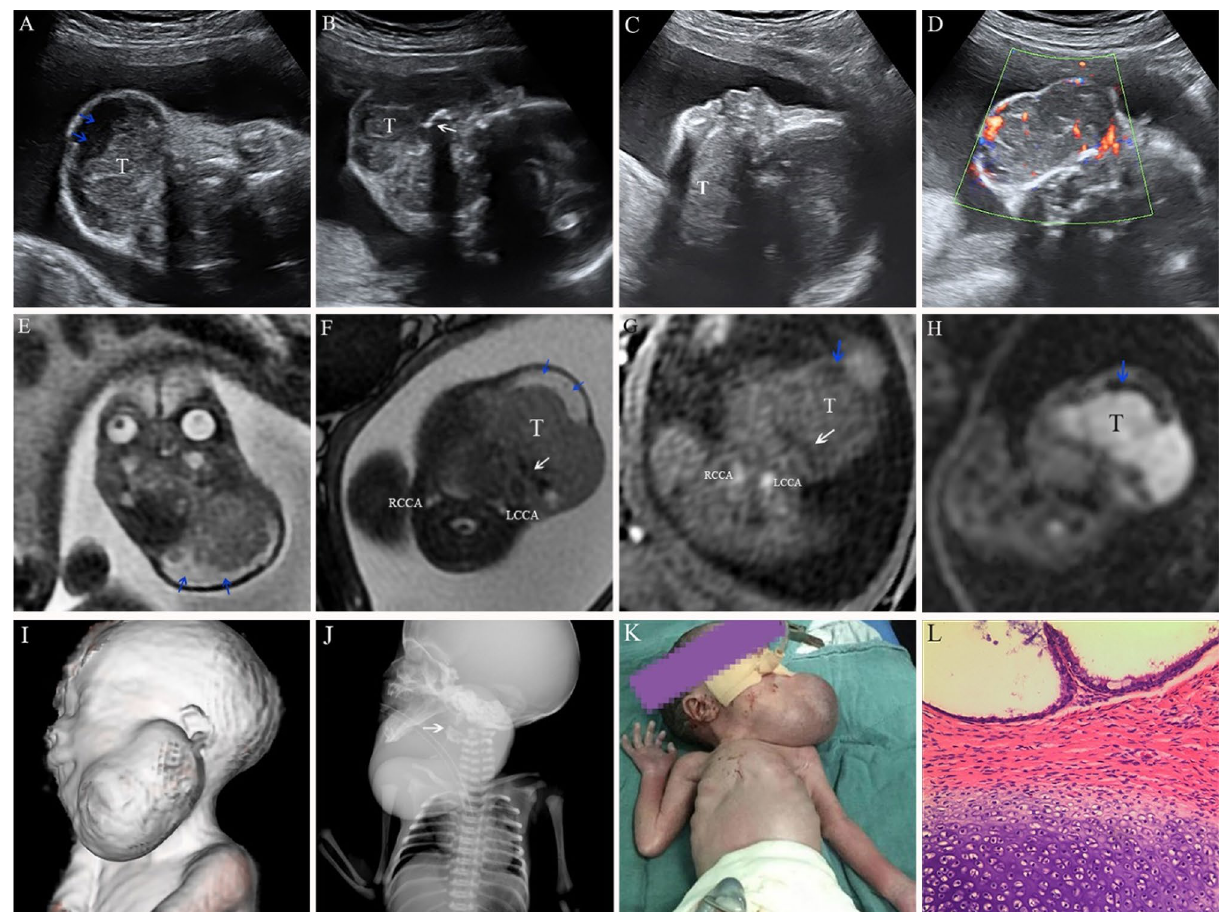
Figure 2. A submandibular teratoma at 29 weeks of gestational age. ( A–D ) Upon prenatal ultrasonic imaging, we found that the giant tumour (T) was with a slightly high intensity echo, high echo lesions with posterior acoustic shadowing at the central region (white arrow), capsule echo at marginal region (blue arrow). Color Doppler imaging showed rich internal blood flow. ( E–I ) On fetal MRI, the lesion was cystic-solid, calcified foci is striped low signal. Diffusion weighted imaging (DWI, b = 800) showed diffusion restriction in solid region (Fig H). Left and right internal carotid arteries were clearly visible (Fig F, Fig G). MR volume reconstruction (VR) image clearly showed the relationship and morphology of mass. ( J ) Neonatal radiography demonstrated huge high-density lesions with calcification (white arrow) under the jaw. ( K ) Image of the newborn after endotracheal intubation. ( L ) The pathological specimen was confirmed to be a mature cystic-solid teratoma (HE staining, × 100 blood flow showed rich blood flow signals inside the hemangioma. Congenital epulis (Fig. 5) was extremely rare in the facial masses. Our results, along with other previous studies, show that the features of neck lesions such as size, invasion, septation, calcification, blood supply, cystic or/and solid lesion, turbid fluid, and so on were well evaluated on prenatal US (Table 2). The multi-modal fetal MRI was a useful adjunct for detecting components of the tumors, and would enhance confidence in the final diagnostic results. In 52 live births cases, the localization of lesions were respectively at the posterior triangle (42.31%), anterior triangle (34.62%), middle neck or submental triangle (15.38%), and oral cavity (7.69%). Prenatal imaging was used to determine the disease process, location, origin, extent, and resectability of the lesions 13,29 . Additionally, through regular follow ‐ up by prenatal ultrasound, we found that the bigger the initial diameter is, the bigger the relative change during pregnancy, and 2 cases were spontaneous. Moreover, the mean measurements between initial diagnosis and last measurement before delivery were statistically significant ( p < 0.01). According to previ- ous studies 30,31 , a sudden increase in size may indicate intratumoral hemorrhage. Therefore, clinical management of its dynamic growth during middle or late gestation in pregnancy is important. Therefore, routine ultrasound screening in the face and neck during pregnancy is well established, and accurate management of a neck mass is critical. Despite congenital facio-cervical masses being generally benign and developmental 32 , abnormalities may be seen in isolation or in association with central nervous system abnormalities, chromosomal abnormalities, intrauterine fetal death, and adverse prognosis 10,33 . First-trimester cystic hygroma is a frequent finding in general obstetric screening programs. In this study, there was a higher rate of TOP of LMs compared to other cervical masses. Four cases of chromosomal structural abnormality, 5 cases of multiple abnormalities, 9 cases of fetal